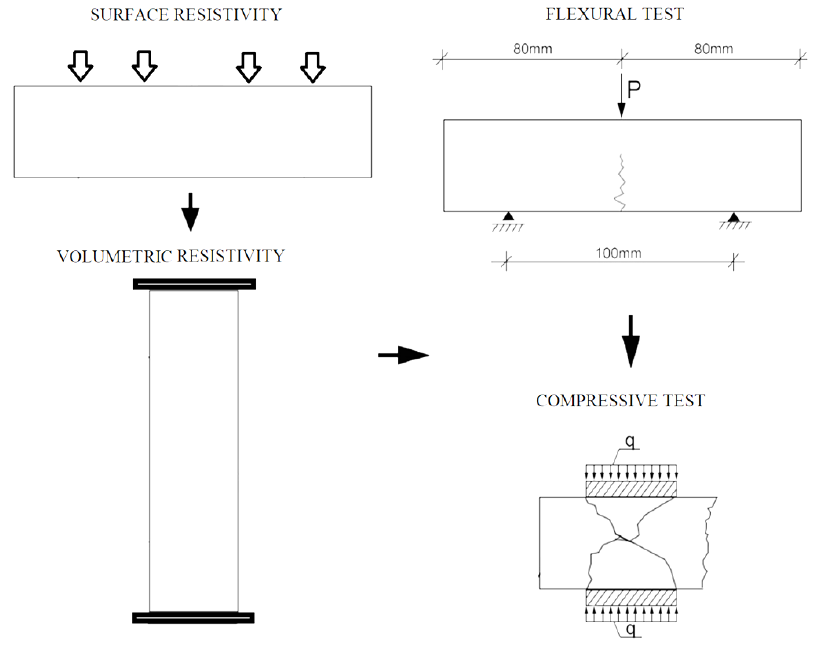
Figure 1. The process of using the samples for surface resistivity, volumetric resistivity, flexural test, and compressive strength. and compressive